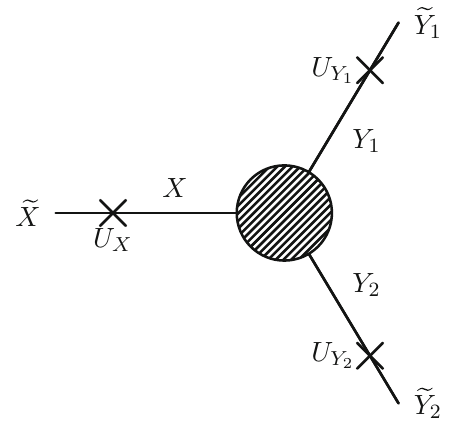
Fig. 3 Schematic picture of our method to include higher-order mass andmixingcorrections.ThecalculationpresentedinSect.2iscombined with external normalisation factors and external loop-corrected